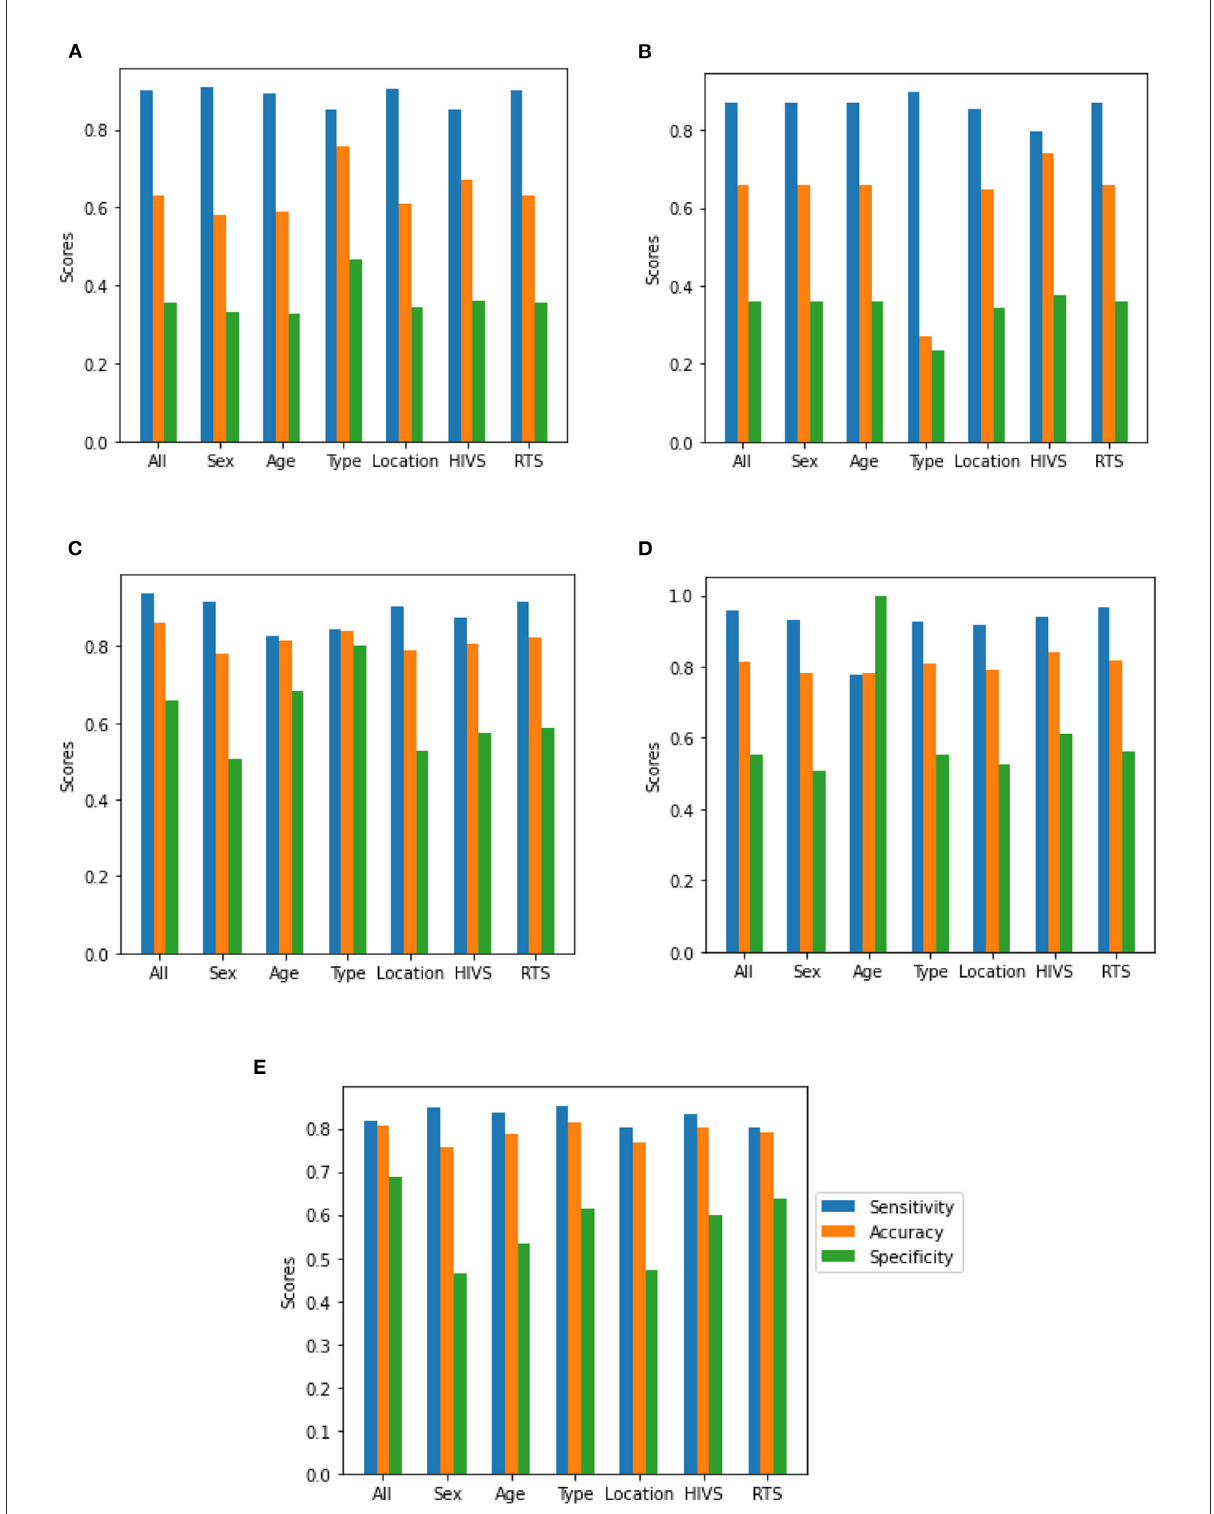
FIGURE2 Sensitivity, accuracy, and specificity for all five ML models: (A) Logistic regression; (B) Classification tree; (C) Random forest; (D) Support vector machine; (E) Multilayer perceptron neural network. For all ML models is visualized the effect of using or not each one of the considered variables in terms of sensitivity (blue), specificity (green) and accuracy (orange). There it is possible to see how the metrics change, according to the inclusion or exclusion of the seven